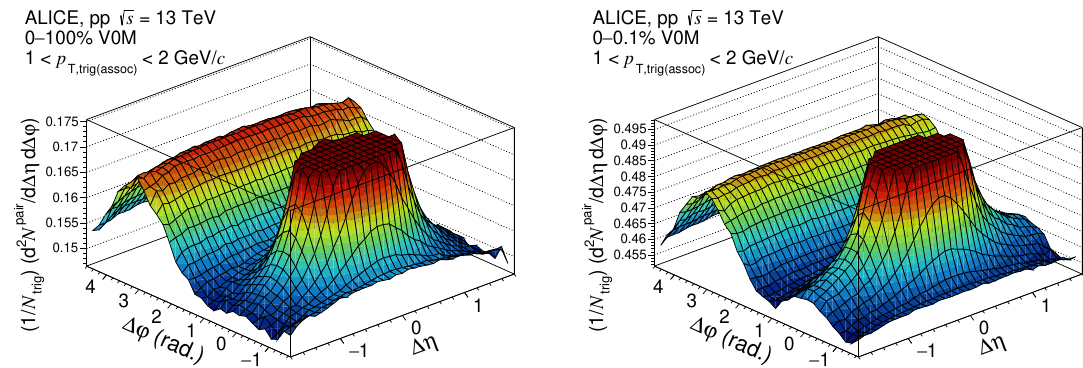
Figure 1 . Two-particle correlation functions as functions of ∆ η and ∆ ϕ in minimum-bias events (0–100%, left) and high-multiplicity (0–0.1%, right). Note that the near-side jet peaks exceed the chosen range of the z -axis. The intervals of p T , trig and p T , assoc are 1 < p T < 2 GeV/ c in both